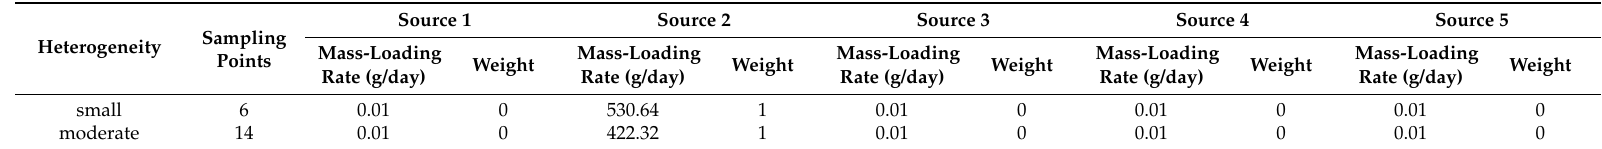
Table 6. Sensitivity analysis results of the heterogeneity of hydraulic conductivity